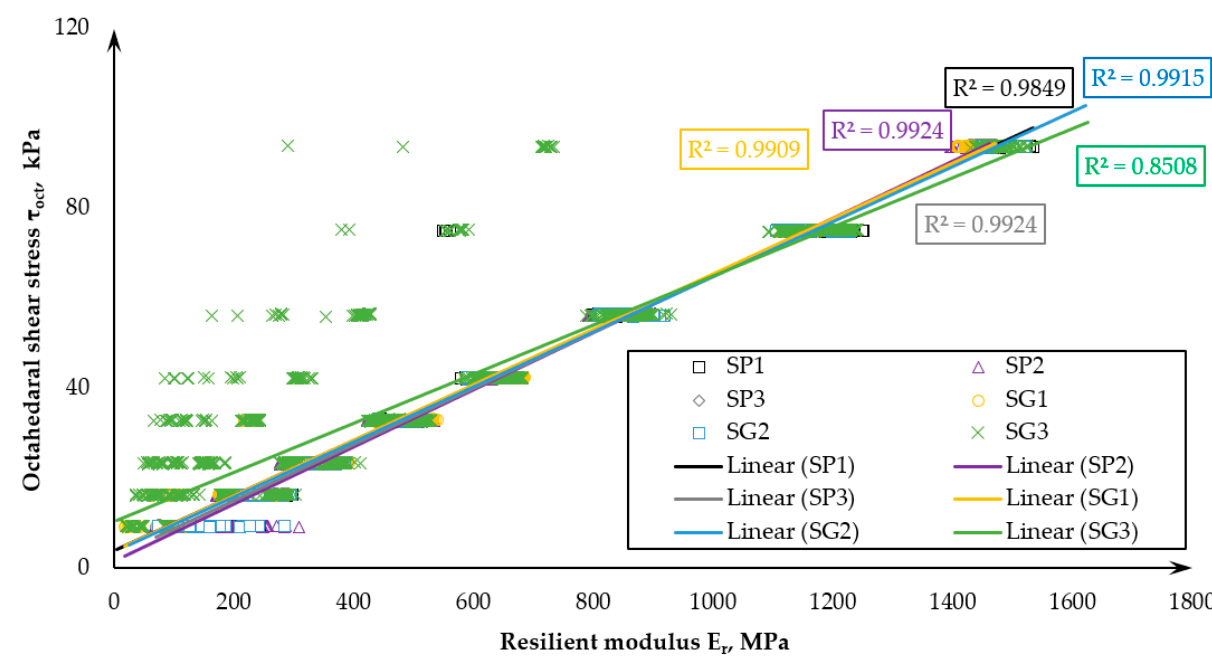
Figure 7. Resilient modulus correlation with octahedral shear stress.